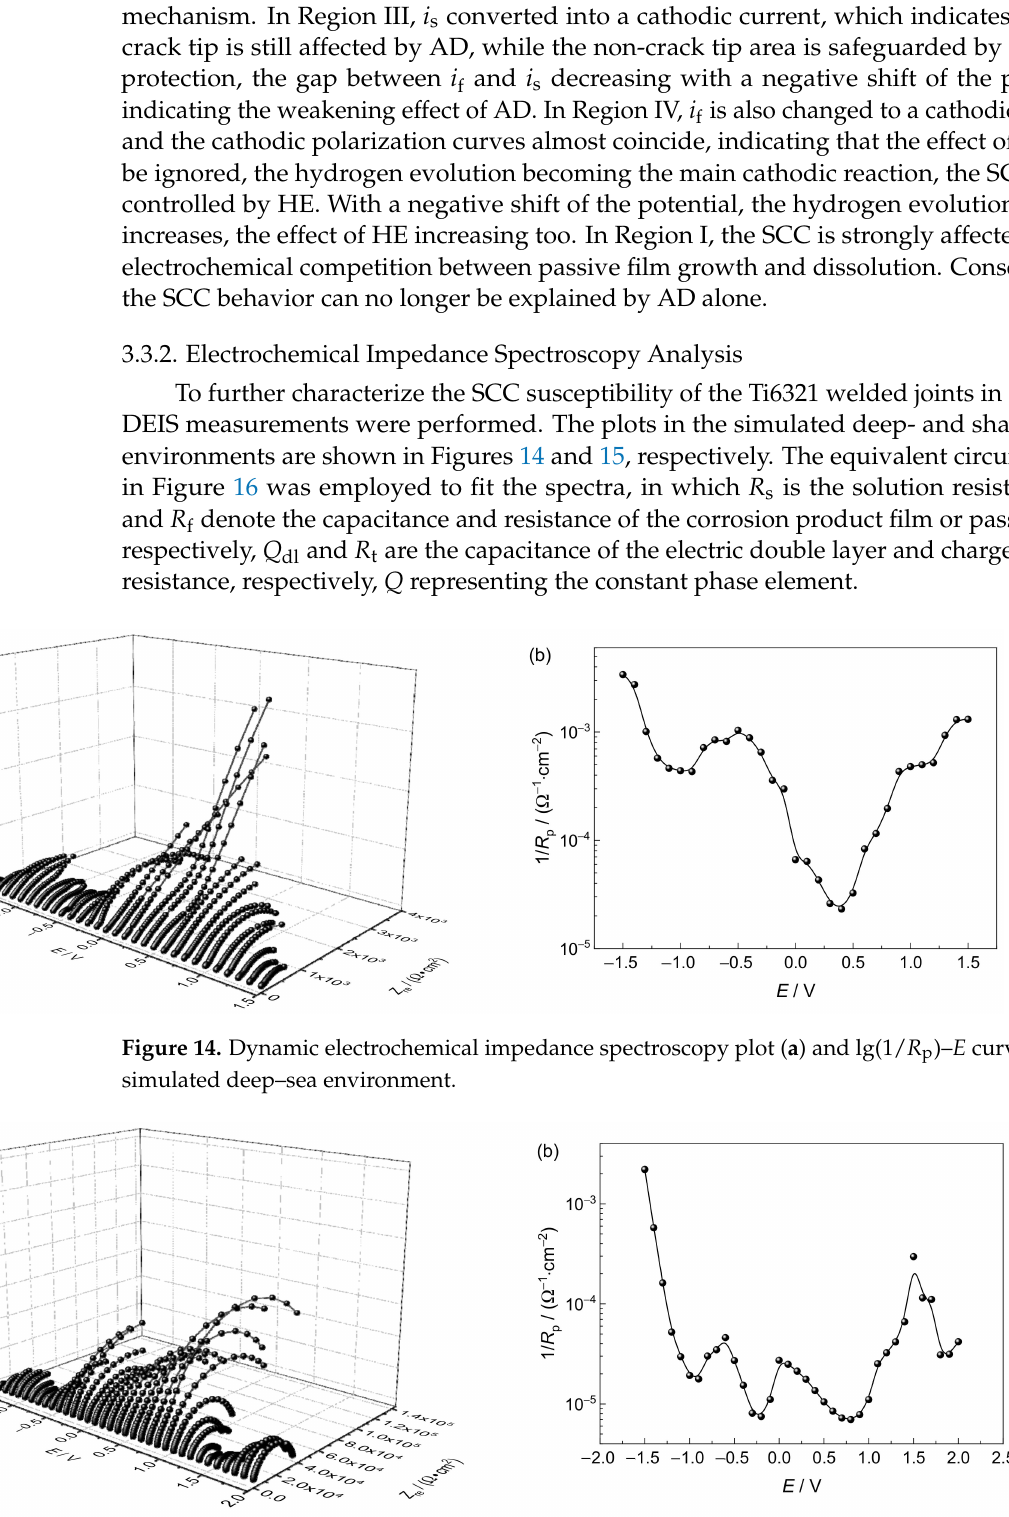
Figure 15. Dynamic electrochemical impedance spectroscopy plot ( a ) and lg(1/ R p )– E curve ( b ) in a simulated shallow − sea